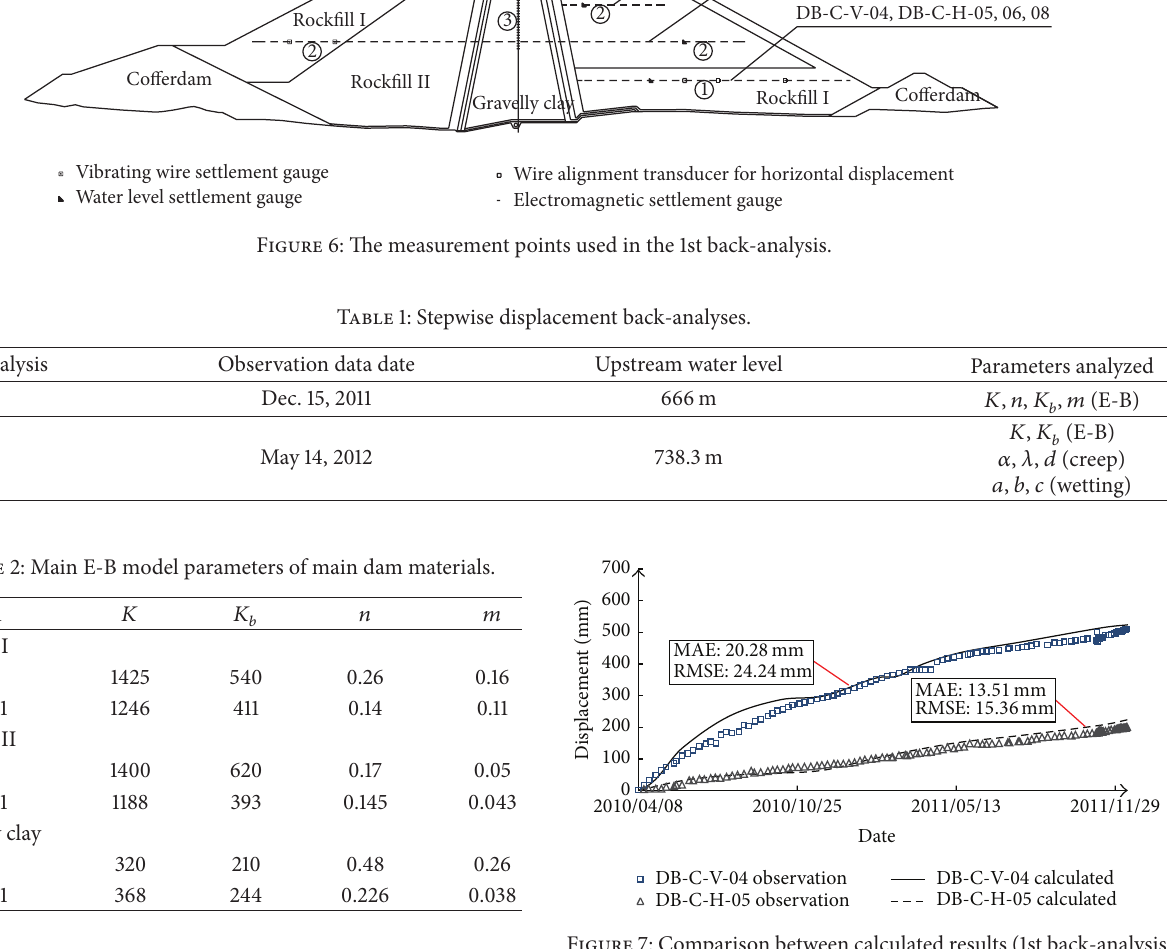
Figure 7: Comparison between calculated results (1st back-analysis parameters) and observation